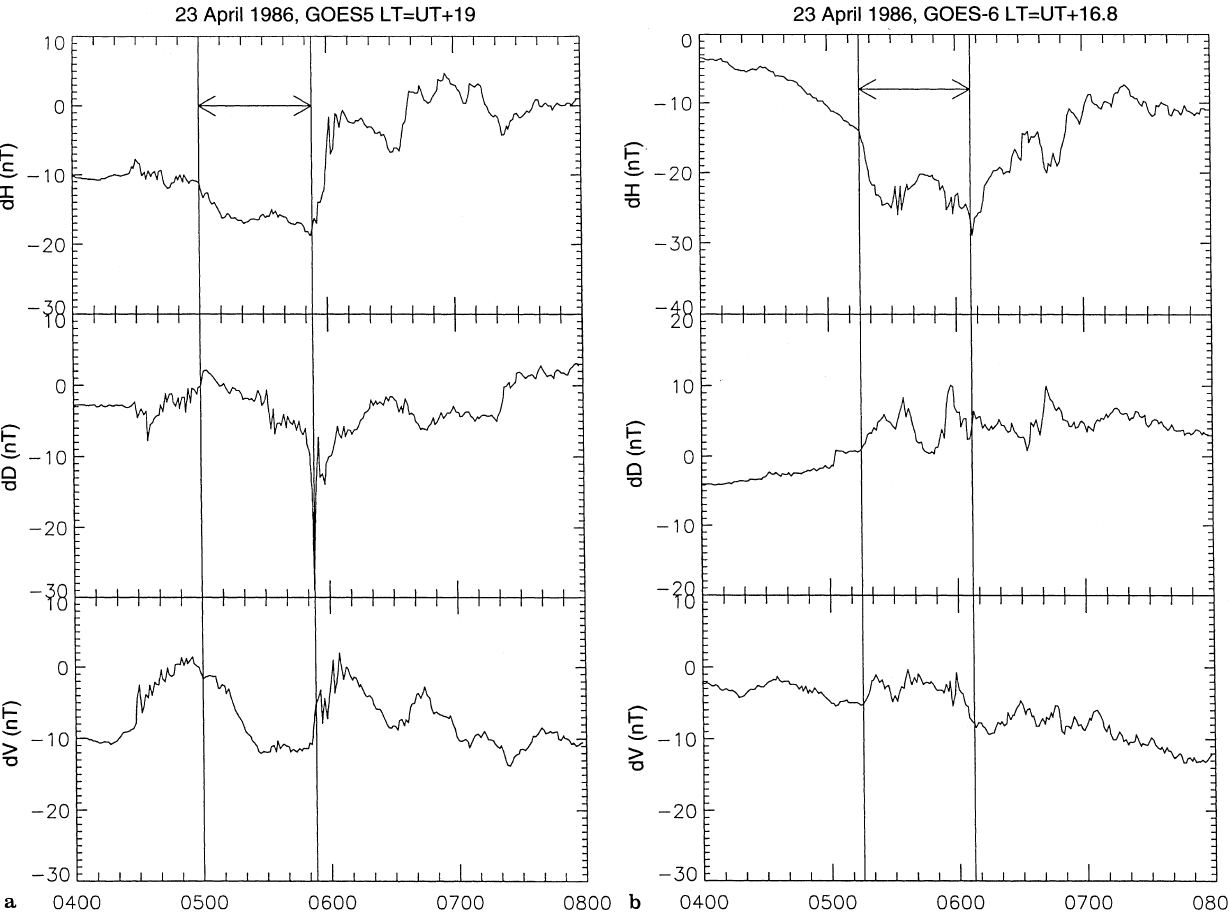
disturbance data from GOES-6 in VDH coordinates on April 23, 1986. The interval between the two lines at 0513 UT and 0607 UT corresponds to the growth phase at GOES-6 position. At 0607 UT GOES-6 detects the dipolarization of